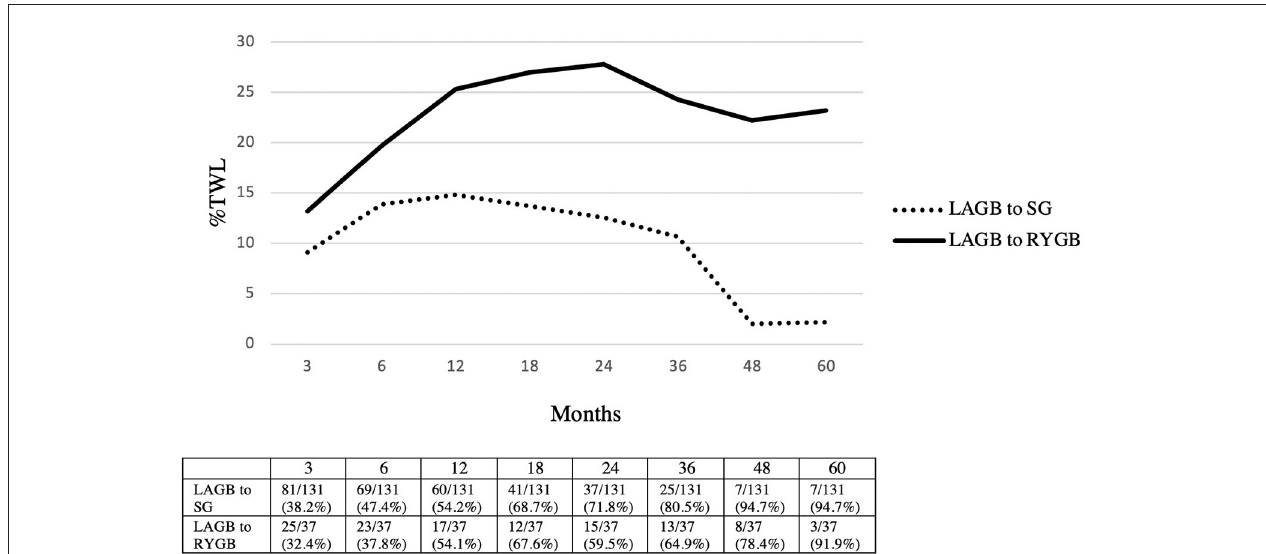
FIGURE 2 | Weight loss outcomes in LAGB to SG vs. LAGB to RYGB. Patients seen/available patients (% loss to follow-up). LAGB, laparoscopic adjustable gastric banding; SG, sleeve gastrectomy; RYGB, Roux-en-Y gastric bypass; %TWL, total weight